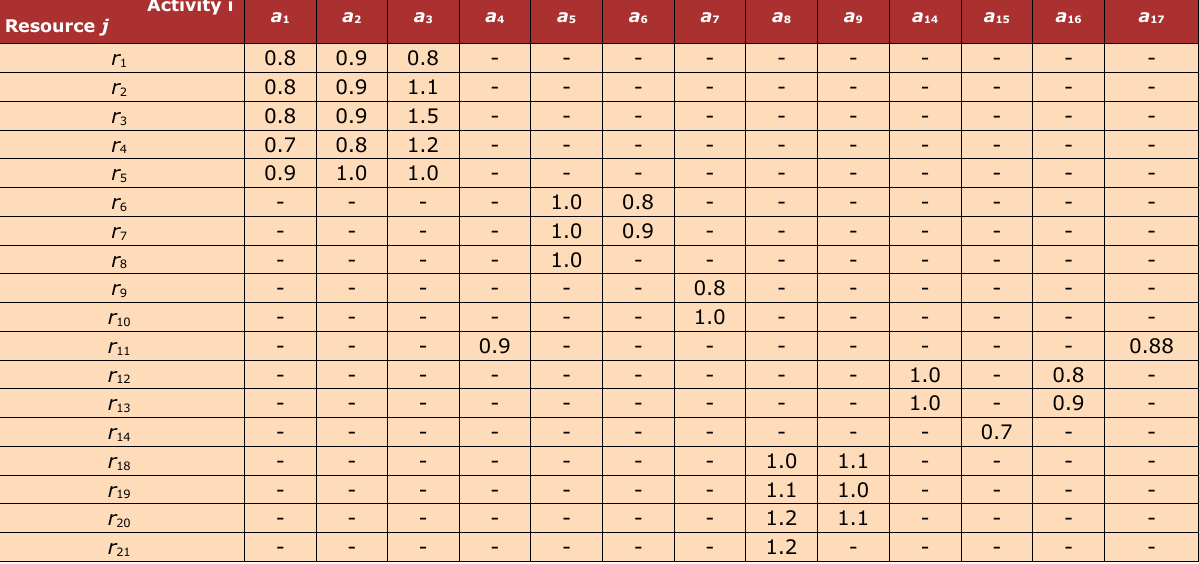
Table 3. Cost information for